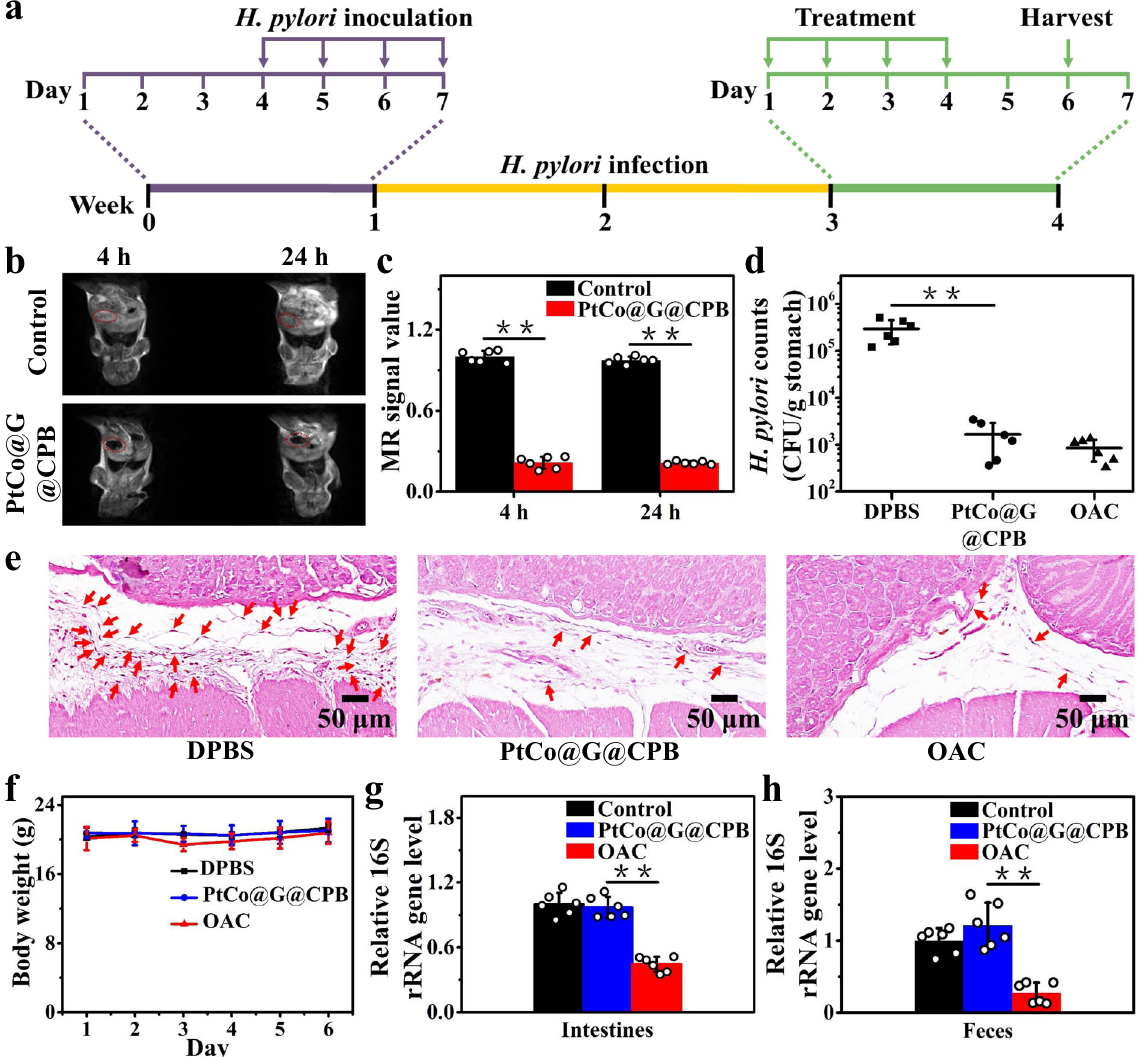
Fig. 4 In vivo therapeutic effect of PtCo@G@CPB. a The study protocol of H. pylori inoculation, infection development, and treatment in BALB/c mice. b Retention time of PtCo@G@CPB in the stomach of H. pylori -infected mouse. c Corresponding data analysis of mouse stomach in b . Data are presented as mean ± SD ( n = 6 biologically independent mice). P values were calculated by the Student ’ s two-sided t -test: ** p < 0.01. d Bacterial burden in the stomach of H. pylori -infected mice treated with DPBS, PtCo@G@CPB, and triple therapy. Data are presented as mean ± SD ( n = 6 biologically independent mice). P values were calculated by the Student ’ s two-sided t -test: ** p < 0.01. e Gram staining of slice from the gastric mucosa receiving DPBS, PtCo@G@CPB, and OAC treatments. Red arrows point to bacteria. f Bodyweight change of mice following treatment of various formulations as in d . Data are presented as mean ± SD ( n = 6 biologically independent mice). The side effects of PtCo@G@CPB against symbiotic bacteria in g intestine and h feces of mice. Data are presented as mean ± SD ( n = 6 biologically independent mice). P values were calculated by the Student ’ s two-sided t -test: ** p < 0.01. Source data are provided as a Source Data fi